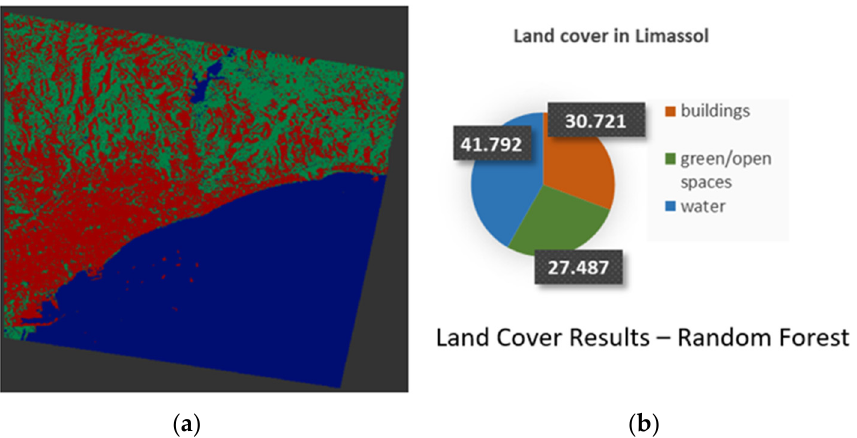
Figure 8. Classification Results in Limassol from the synergetic use of SAR and optical data: ( a ) Random Forest output; ( b ) Land Cover.